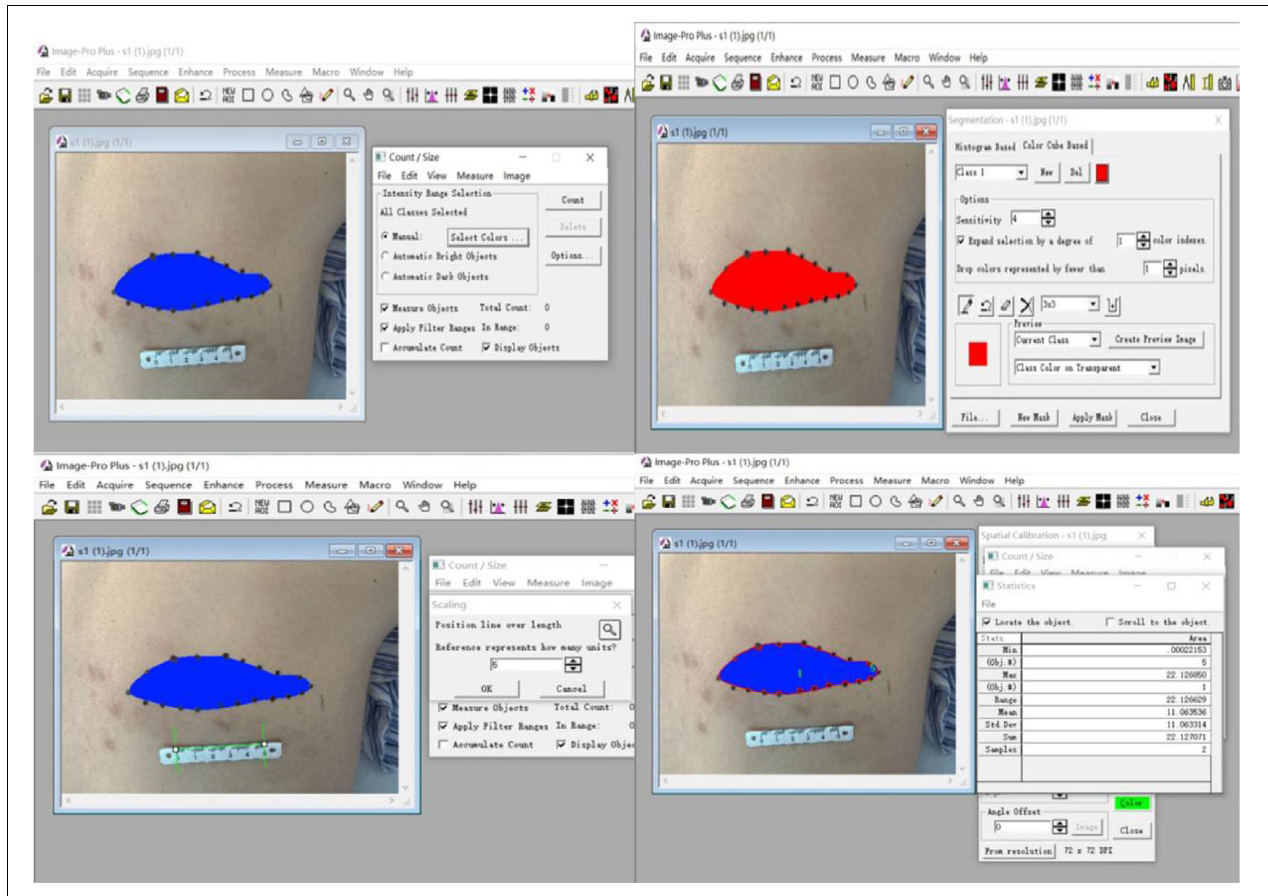
FIGURE 5 | Measurement of the numbness area using Image-Pro Plus 6.0 software.